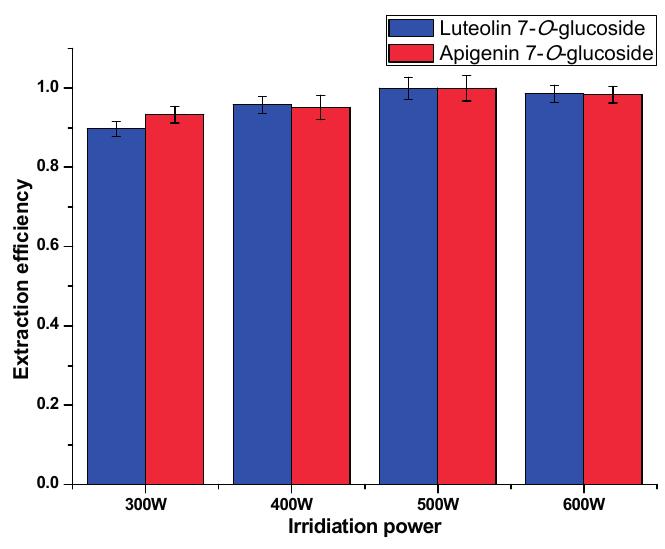
Figure 8. Extraction efficiency under different irradiation